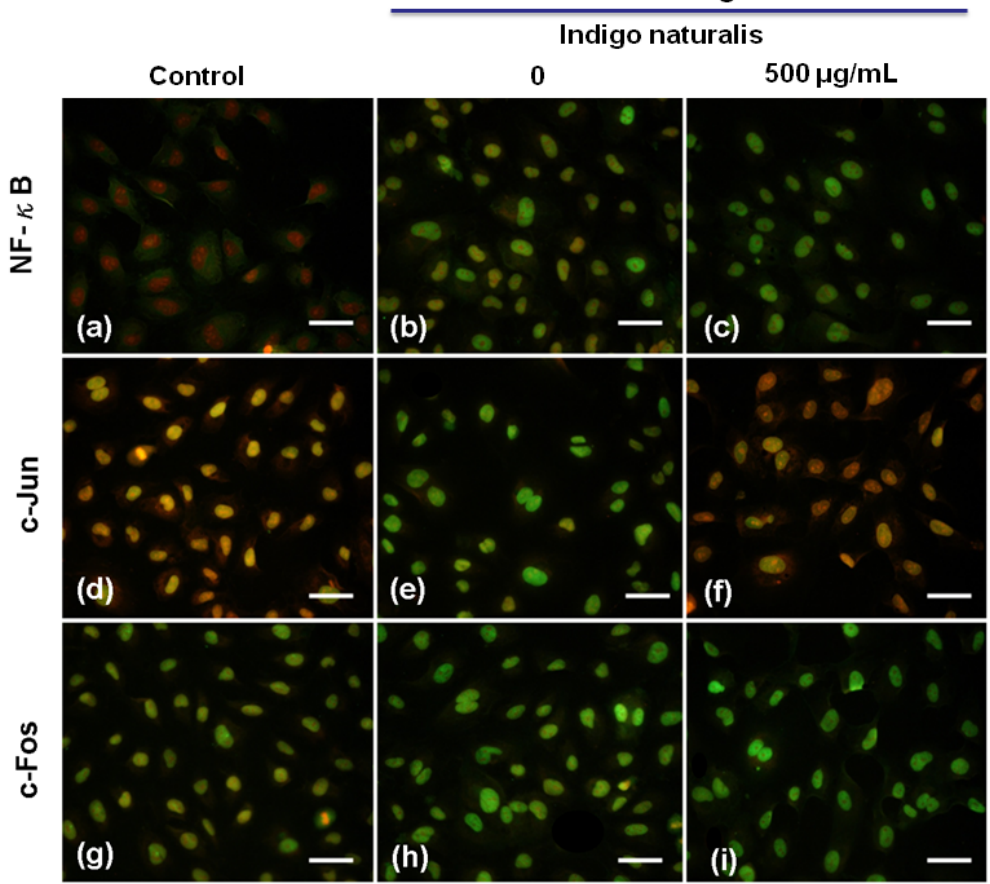
Figure 4. Effect of indigo naturalis extract on protein expression of NF- κ B, c-Jun and c-Fos on